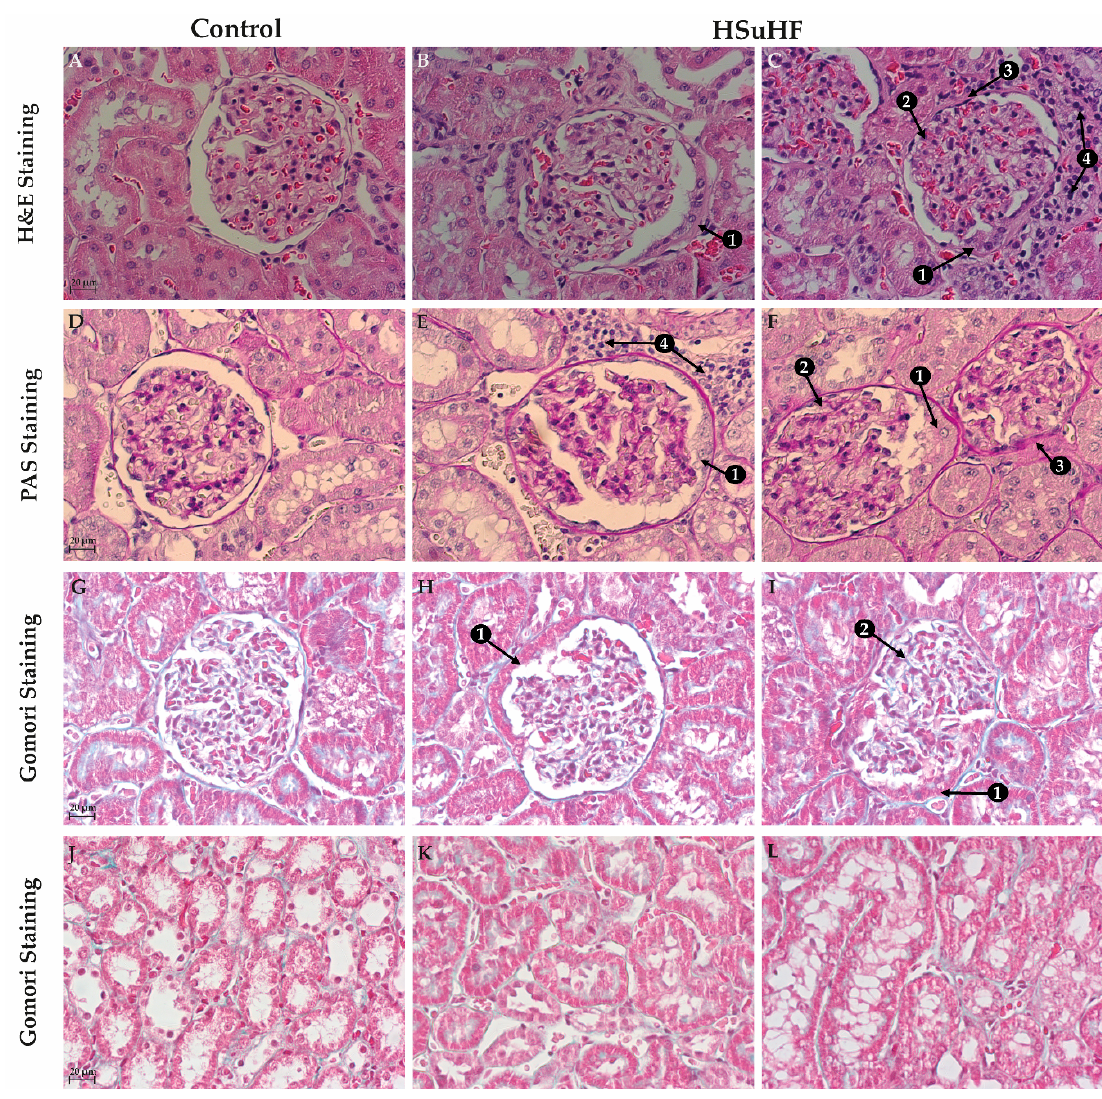
Figure 2. Representative images of glomerular (A–I) and tubulointerstitial (J–L) regions and lesions in the Control and HSuHF-treated rats ( n = 8 per group) evaluate by H&E, PAS and Gomori staining (all with 40X amplification). Arrows represent the glomerular lesions better identified in the above description of results: 1) the presence of glomerular crescent-like structures; 2) mesangial expansion; 3) thickening of the GBM; 4) focal inflammatory infiltrate.